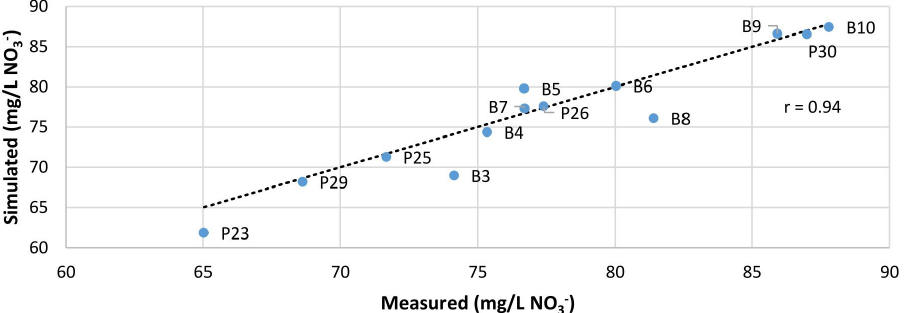
Figure 6. Comparison of measured and simulated values of nitrate concentrations at the control points. Table 3. Estimated values of nitrate concentration in the area of point sources of pollution.